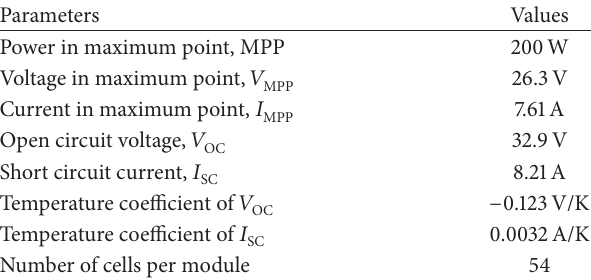
Table 1: Specifications of solar KC200GT at 1000 W/m 2 and 25 ∘